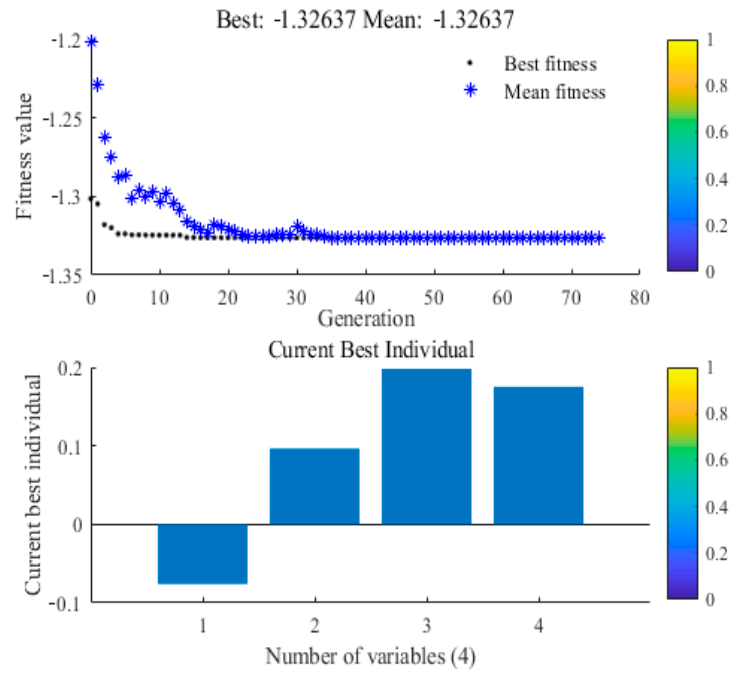
Figure 4. Best fitness and best individual graph.